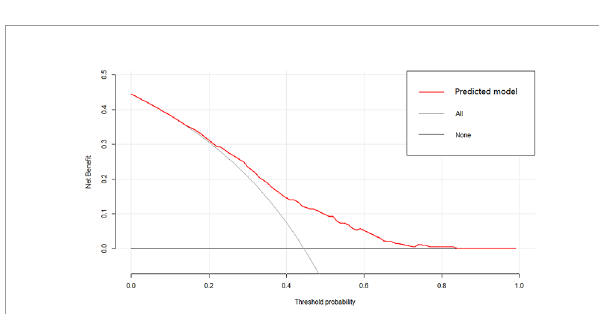
FIGURE 5 | Decision curve analysis showed that patients had a good net bene fi t from this